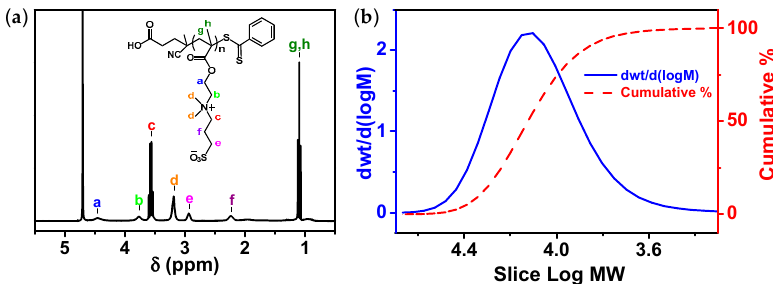
Figure 1. ( a ) 1 H-NMR spectrum and ( b ) Gel permeation chromatography measurement (GPC) curves of PSBMA, where wt is weight, M w is molecular weight.